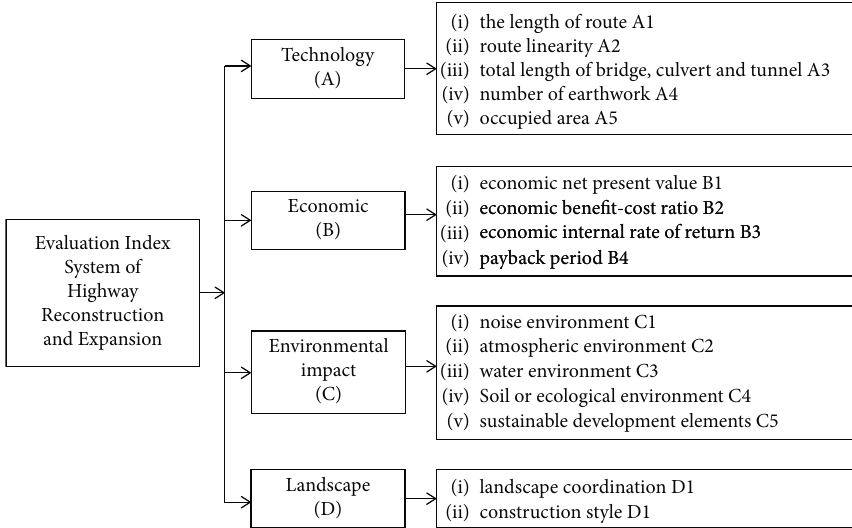
Figure 1: Evaluation index system of